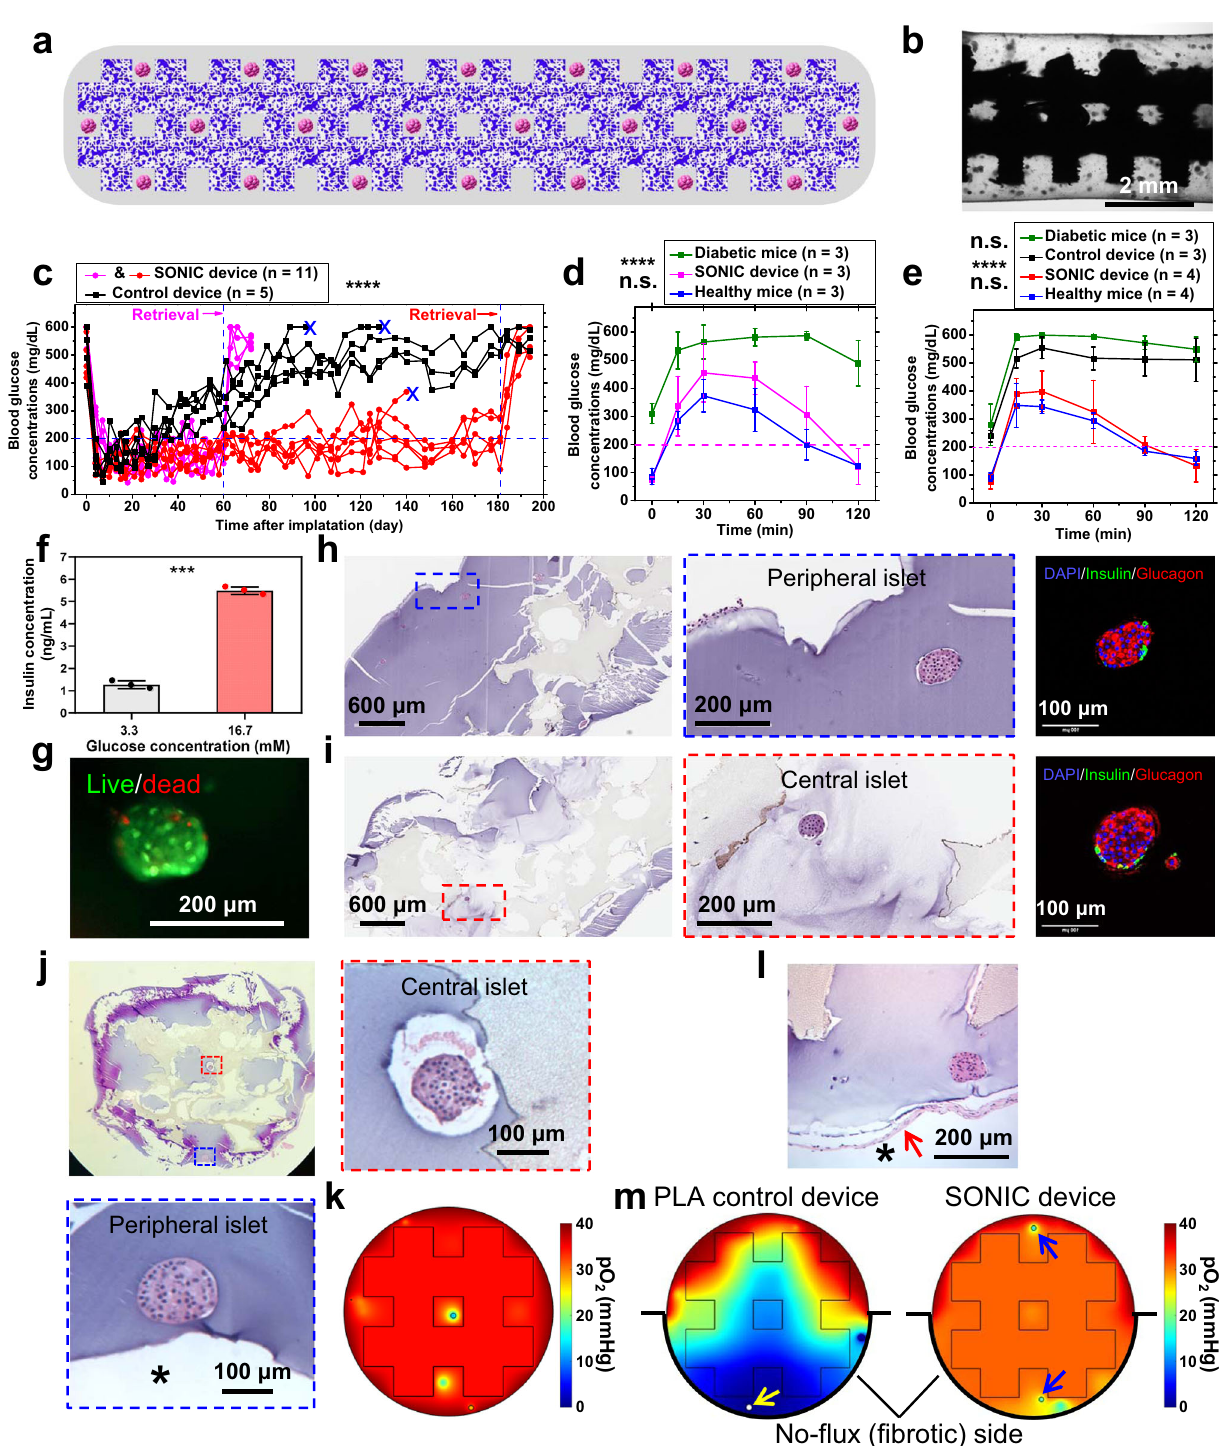
device motivated the exploration of yet a thicker device design (Fig. 6). Our computational model was adapted to simulate the effects of increasing device size prior to fabrication and in vivo testing. A cubic (6.6 × 6.6 × 6.6 mm) control device and SONIC device were considered, each including 500 IEQ of size- distributed rat islets (Fig. 6a, b and Supplementary Fig. 19a). Remarkably, in silico islets in the 6.6 mm-thick SONIC device were similarly oxygenated (with similarly negligible necrosis levels) as the former 4.2 mm device due to the rapid O 2